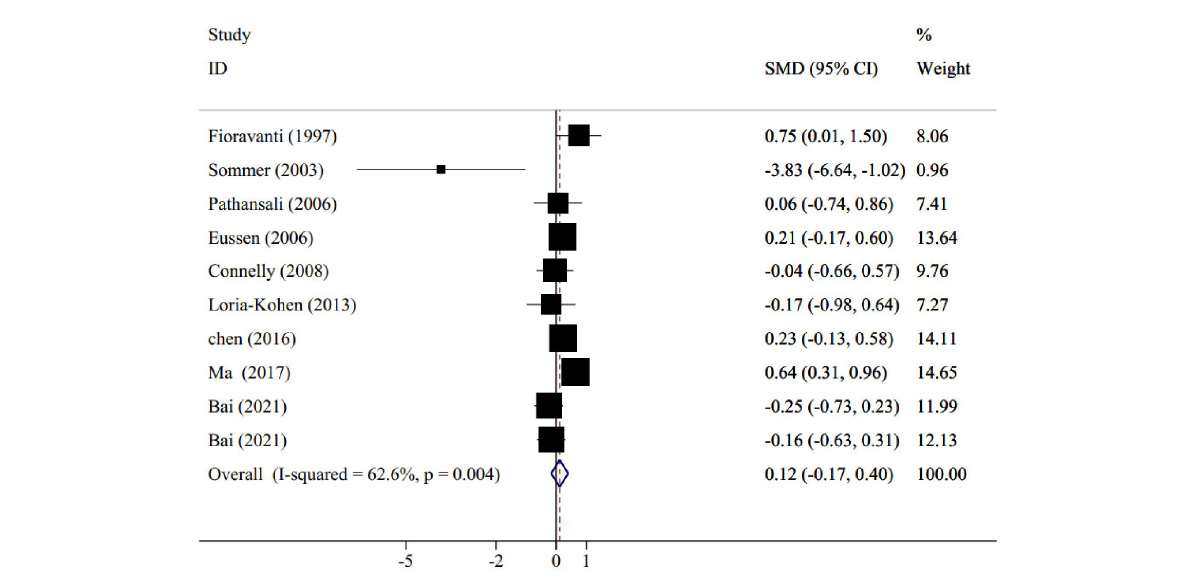
FIGURE2 Forest plot for the effect of folic acid supplementation on memory, expressed as standardized mean differences between intervention and control groups. Weights are from random effects